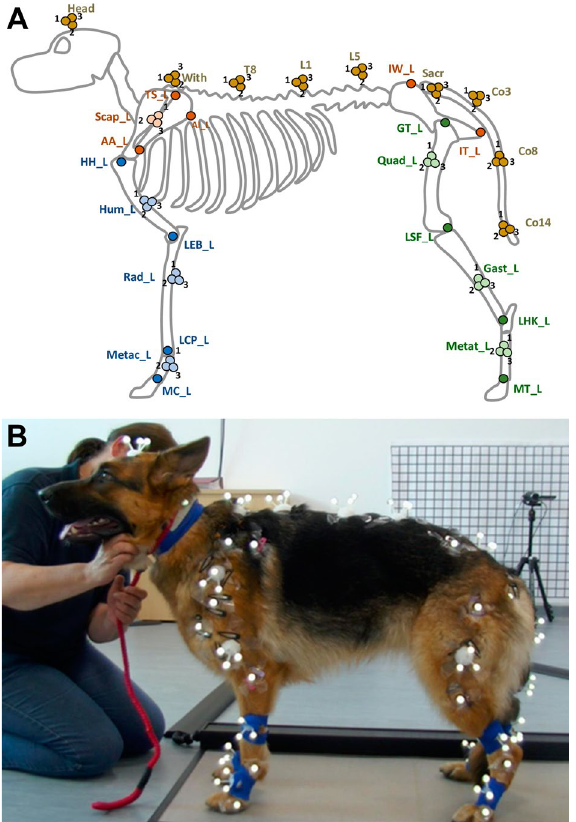
Figure 1. Illustration of reflective marker positions attached at bony landmarks and cluster locations on the left side and back ( A ). Markers were also attached at the same locations to the right limbs. Standing data collected while a GSD stood square on the pressure walkway for 10 s ( B ).